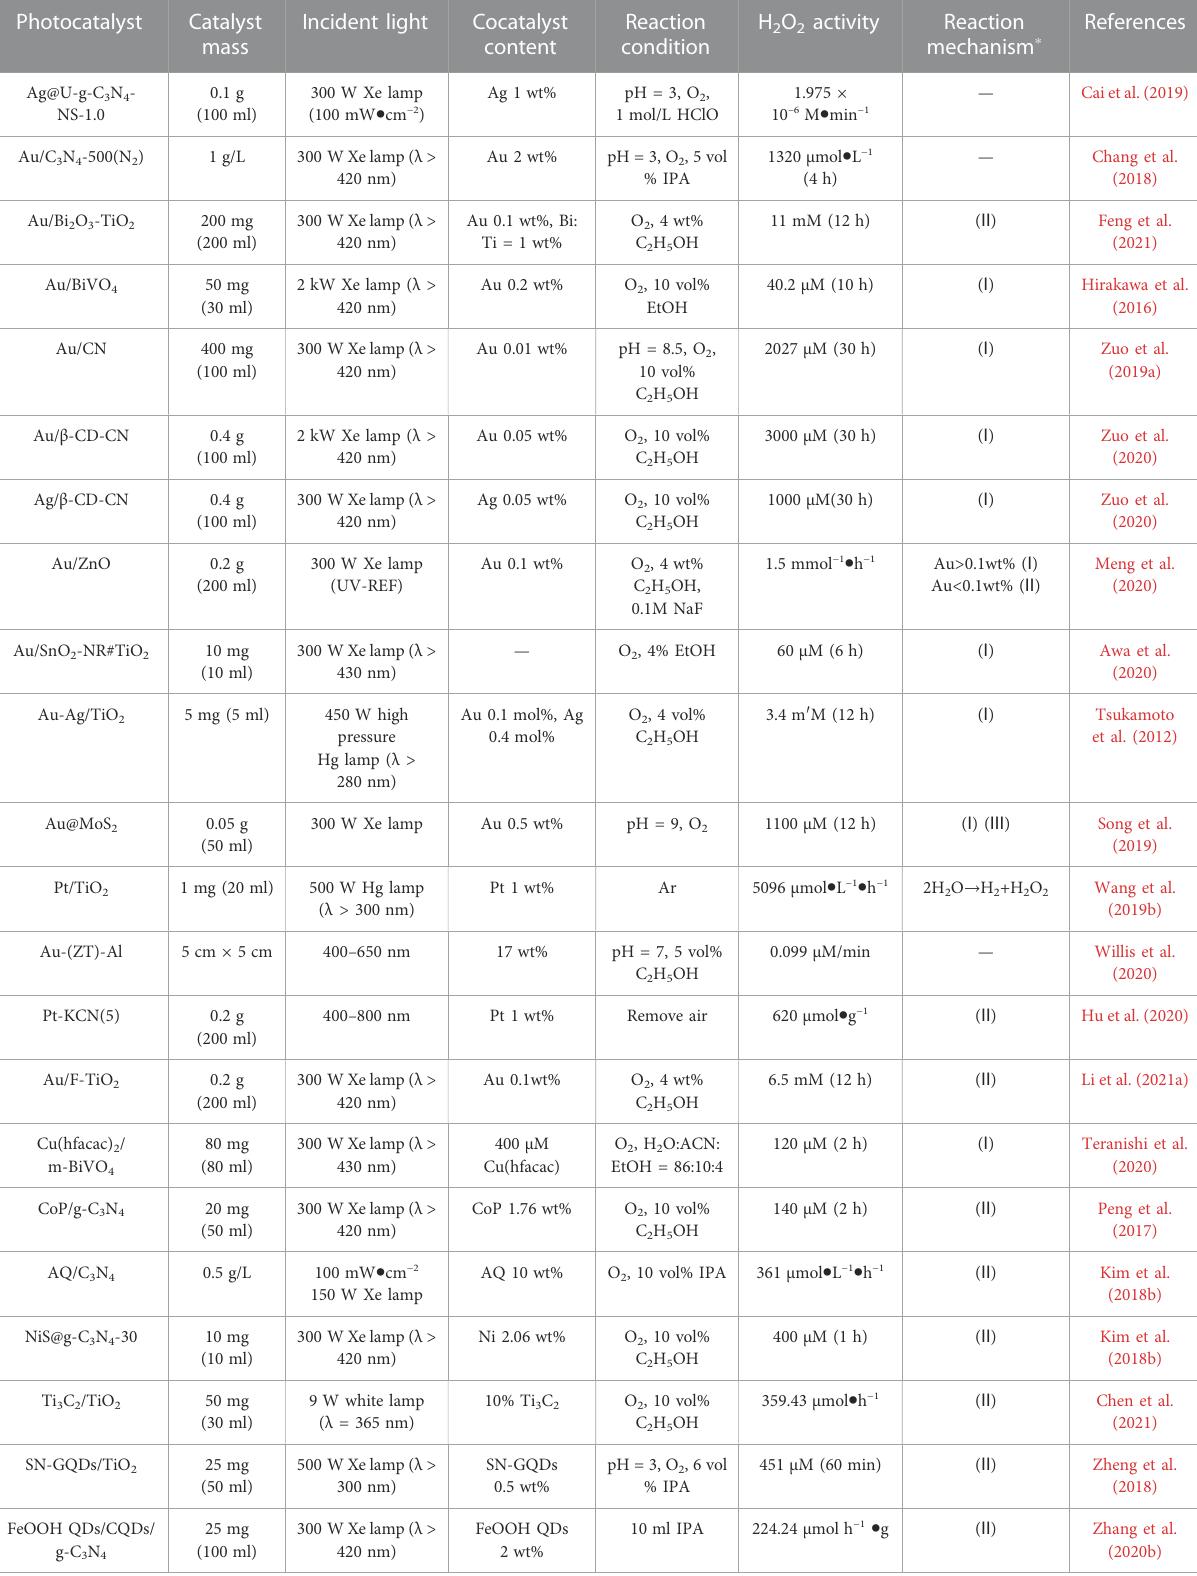
TABLE 1 Activities of photocatalysts with different types of